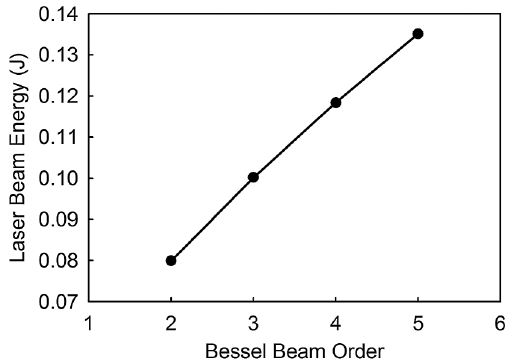
FIG. 8. Dependence of laser pulse energy with Bessel-beam